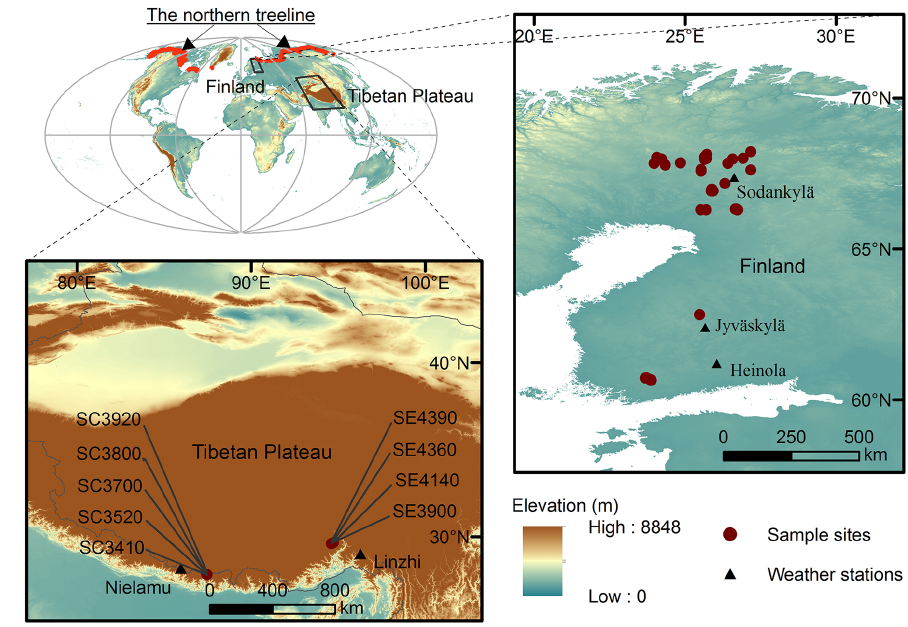
Figure 1. Location map of the sample plots and weather stations in Finland and on the Tibetan